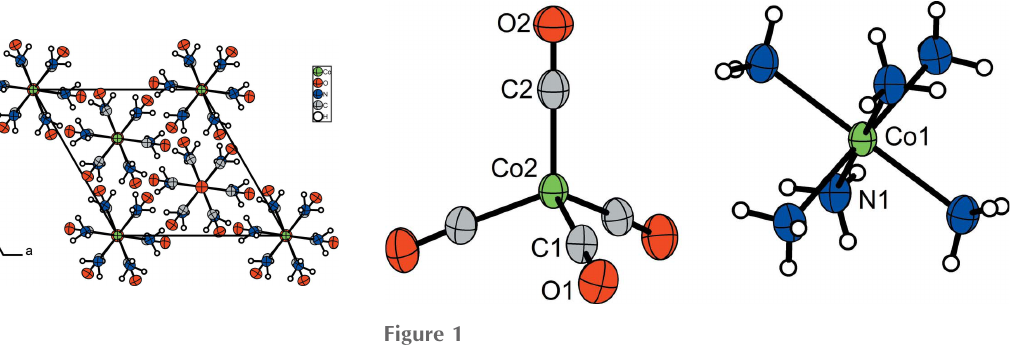
Figure 1 The molecular structures of the tetracarbonylcobaltate( (cid:2) I) anion and of the hexaamminecobalt(II) cation of the title compound. Displacement ellipsoids are shown at the 70% probability level. Labelling of symmetry- equivalent atoms has been omitted for